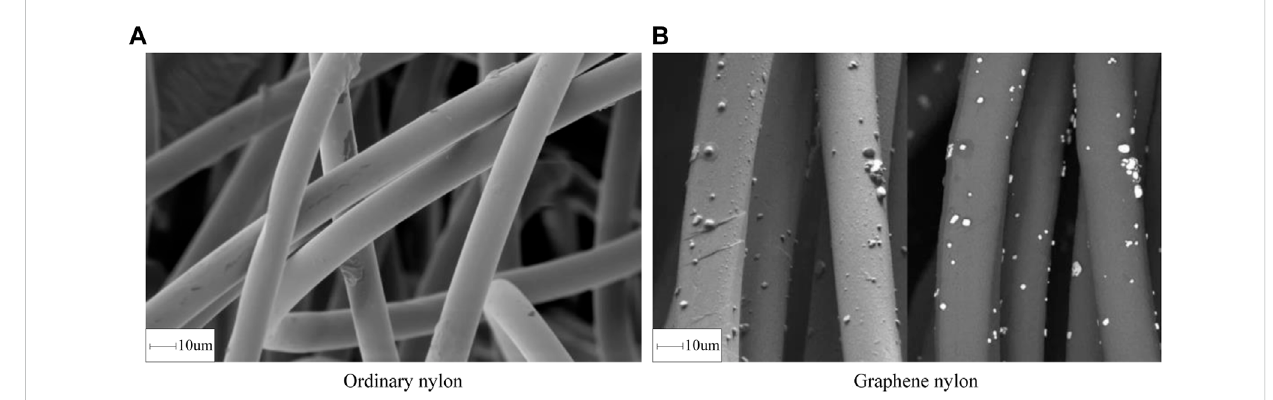
FIGURE 2 Electron microscope photos of ordinary nylon and graphene nylon. (A) Ordinary nylon. (B) Graphene